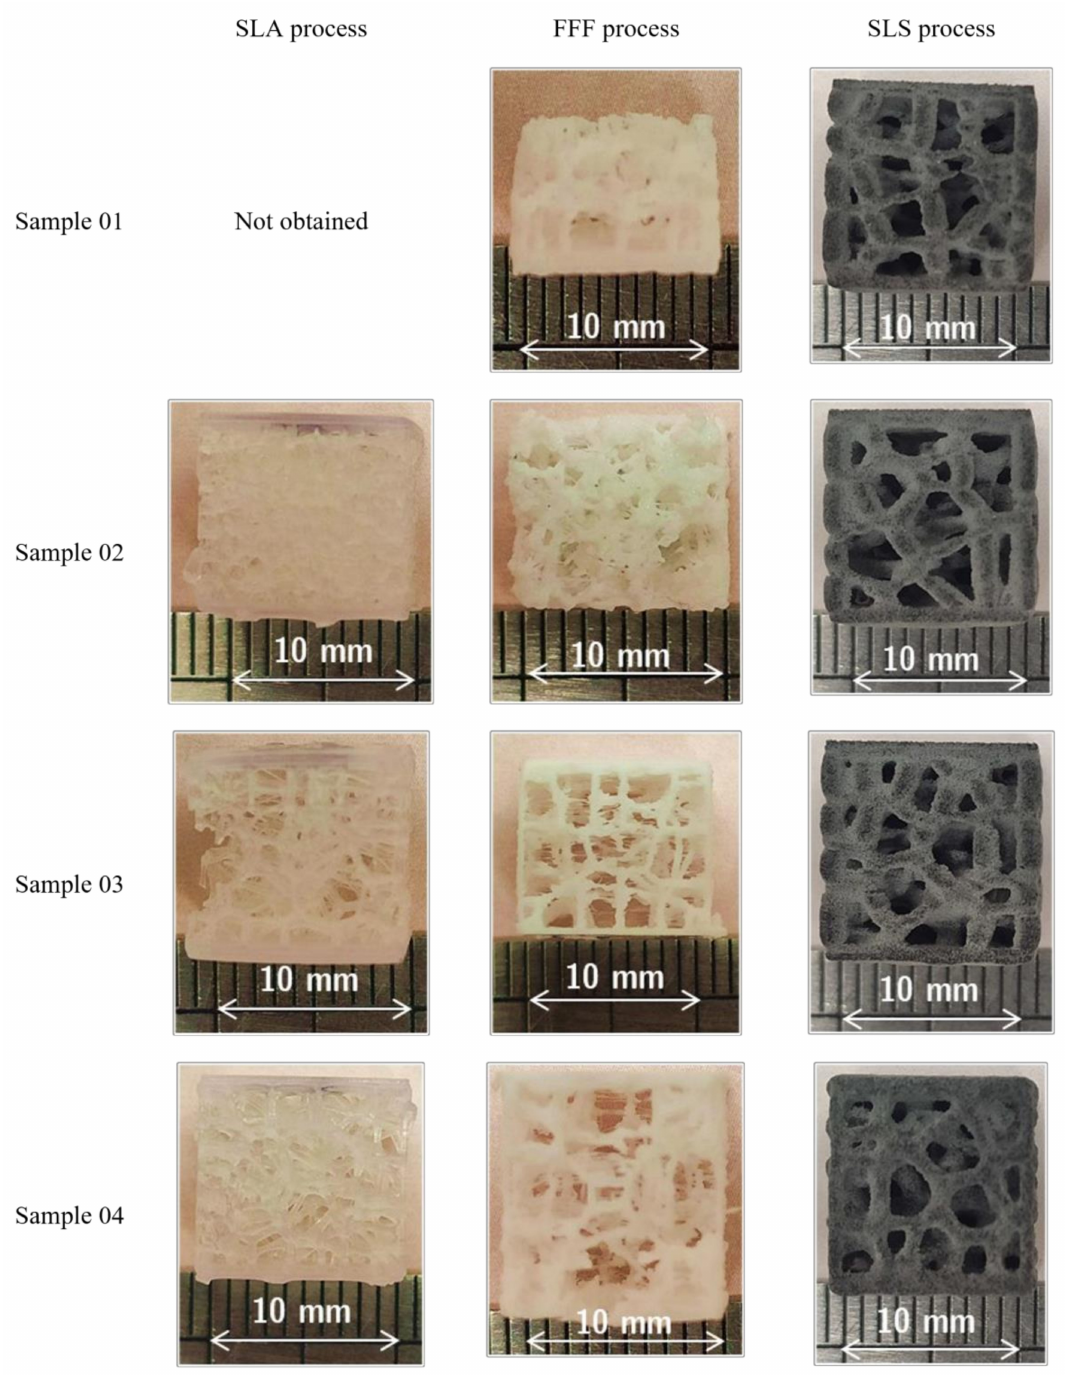
Figure 3. Defects in samples with strut diameters lower than 0.5